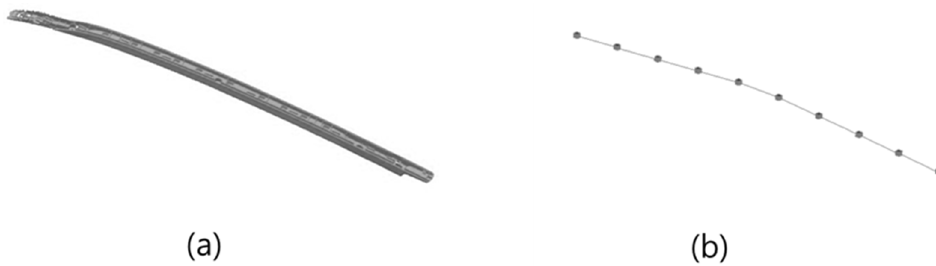
Figure 3. Complex product specimen: ( a ) model; ( b ) geometry for mode shape.